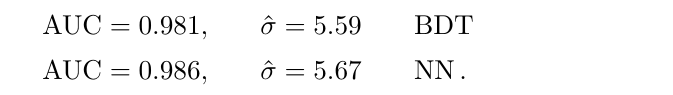
, B: M 1 . 5 GeV, C: P 2 /m B X < m D X < + < m D